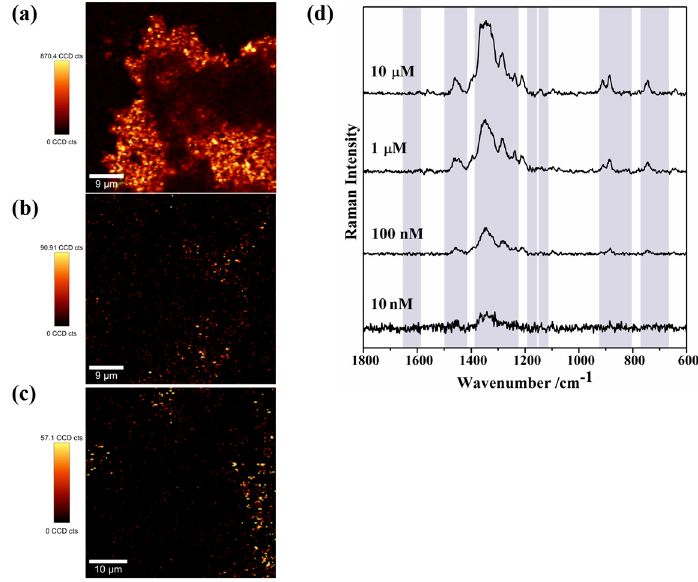
Figure 10. Raman images obtained with the integrated intensity of the band at 1347 cm − 1 of TC recorded using MNP-AuNS as SERS substrate using different TC concentrations: ( a ) 1 µ M; ( b ) 100 nM; and ( c ) 10 nM. The vertical bar shows the colour profile in each image, with the relative intensity scale. ( d ) Single SERS spectra of TC taken from the Raman images using different TC concentrations.